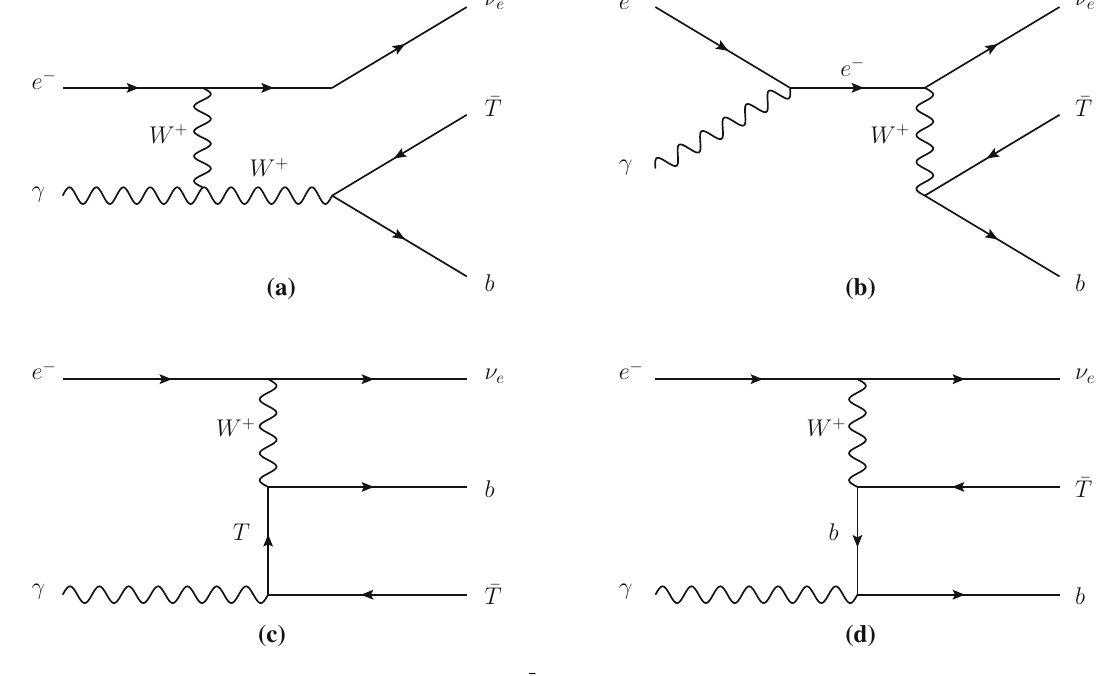
Fig. 2 Leading order Feynman diagram of the process e − γ → ν e b ¯